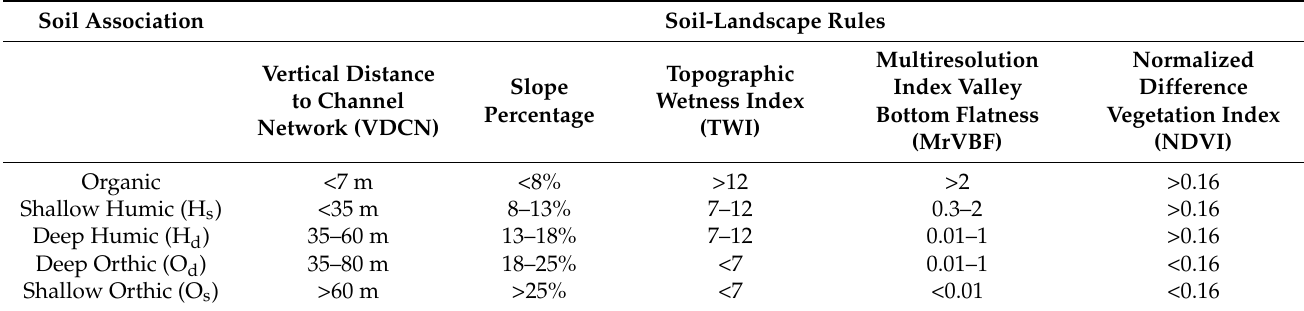
Table 1. Fuzzy membership rules created based on expert knowledge of the landscape in order to create the SoLIM-RB model for the Tugela catchment